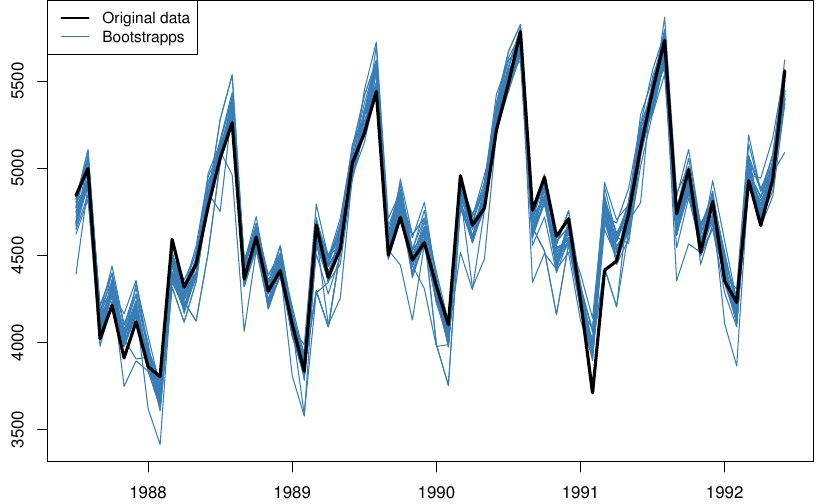
Figure 3. The original data (black line) together with 30 bootstrapped series (blue lines). Effectively, bagging should be seen as a data augmentation (or oversampling) ap- proach applied in univariate settings, in the sense that the amount of modified series added over the existing one for training the forecasting methods and producing the final forecasts are solely based on the series being predicted. This is a key difference compared to the multivariate data augmentation approaches used in the literature for successfully implementing “cross-learning” (or “global”) forecasting methods [60], where the synthetic data share the underlying patterns of multiple series found in a broad set of